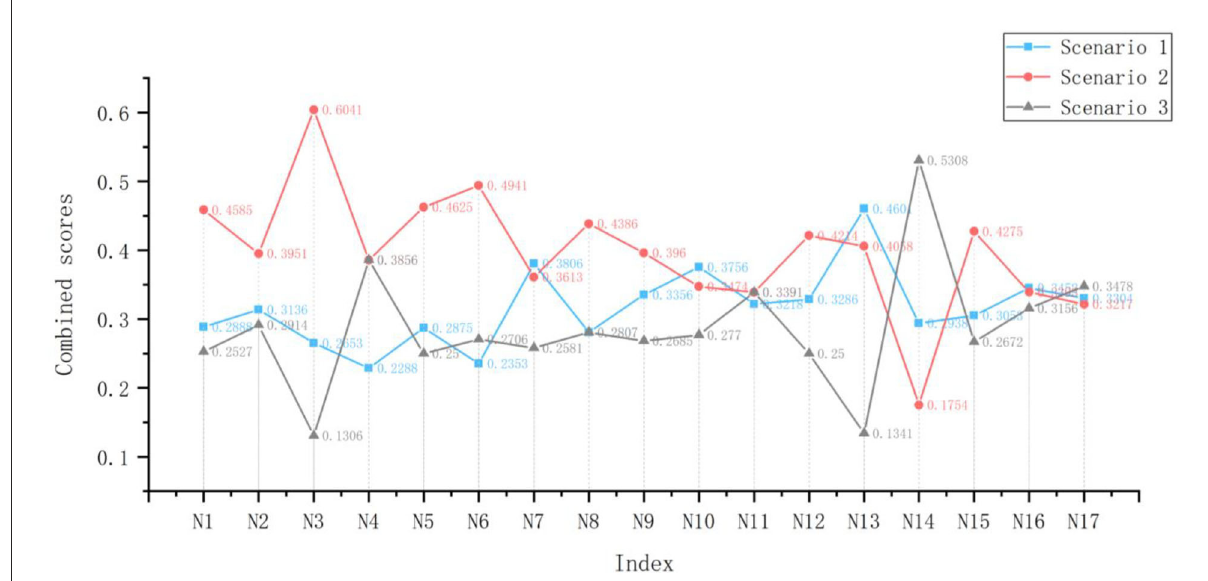
FIGURE4 Combined scores of the programs after normalization. Scenario a is equal to Scenario 1, Scenario b is equal to Scenario 2, Scenario c is equal to Scenario